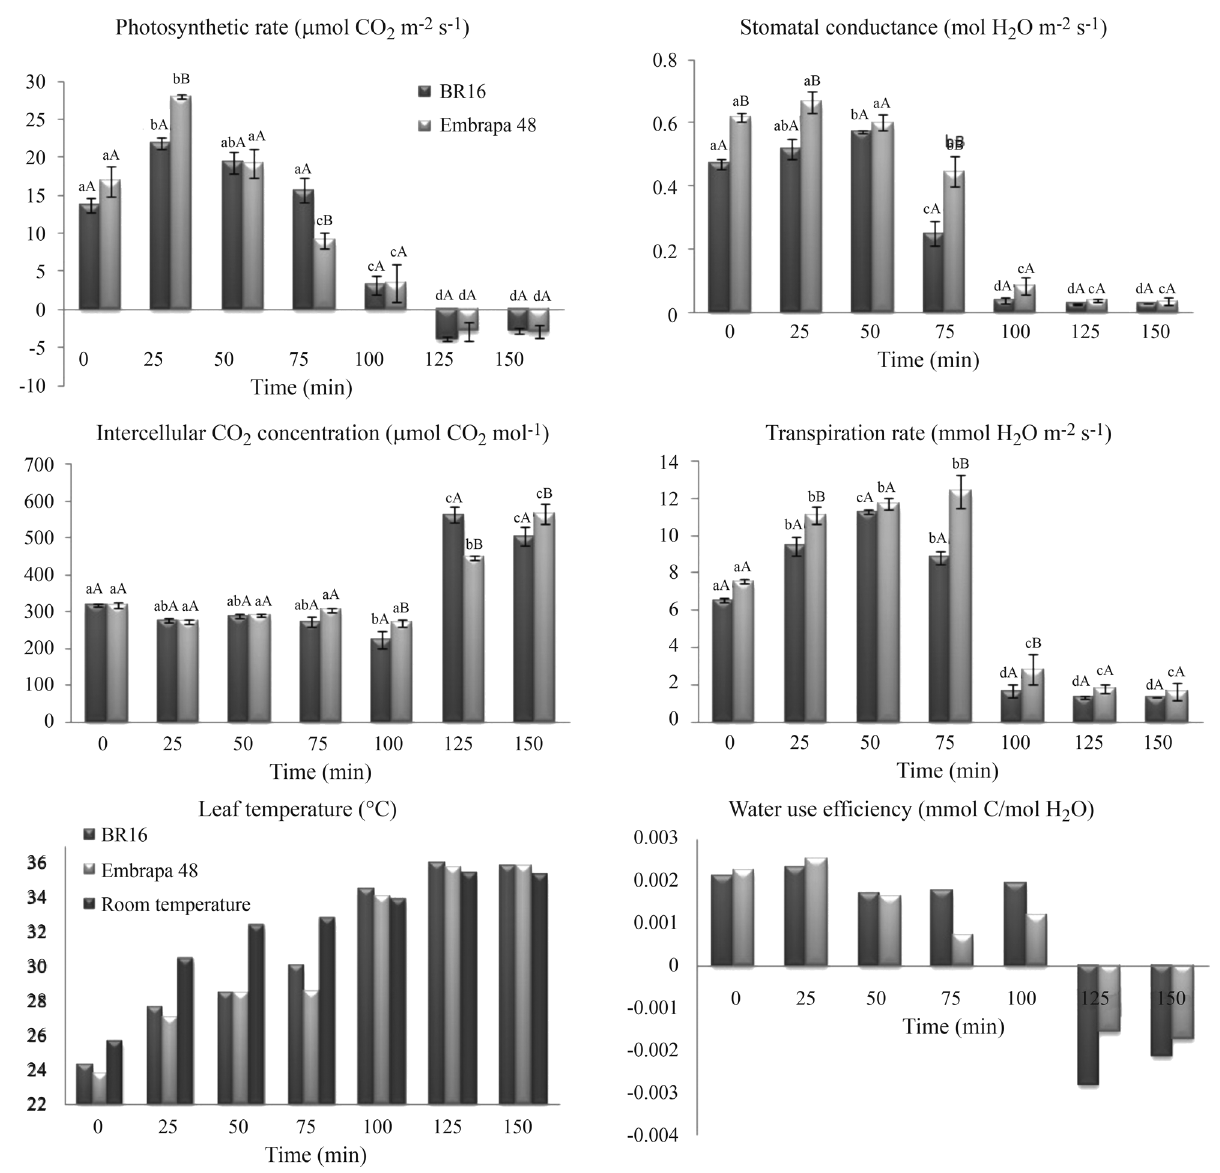
Figure 2 - Physiological parameters measured on drought-stressed plants. Photosynthetic rate ( (cid:3) mol CO 2 m -2 s -1 ), stomatal conductance (mol H 2 O m -2 s -1 ), internal CO 2 concentration ( (cid:3) mol CO 2 mol -1 ), transpiration rate (mmol H 2 O m -2 s -1 ), and leaf temperature (°C) were measured with a LiCor Portable Photosynthesis System. The water use efficiency (mmol C/mol H 2 O) was determined based on transpiration and photosynthetic rate. From each stress treatment, two plants were evaluated in each block. Results represent the mean value of all plants analyzed. The ( (cid:2) ) standard error bars are